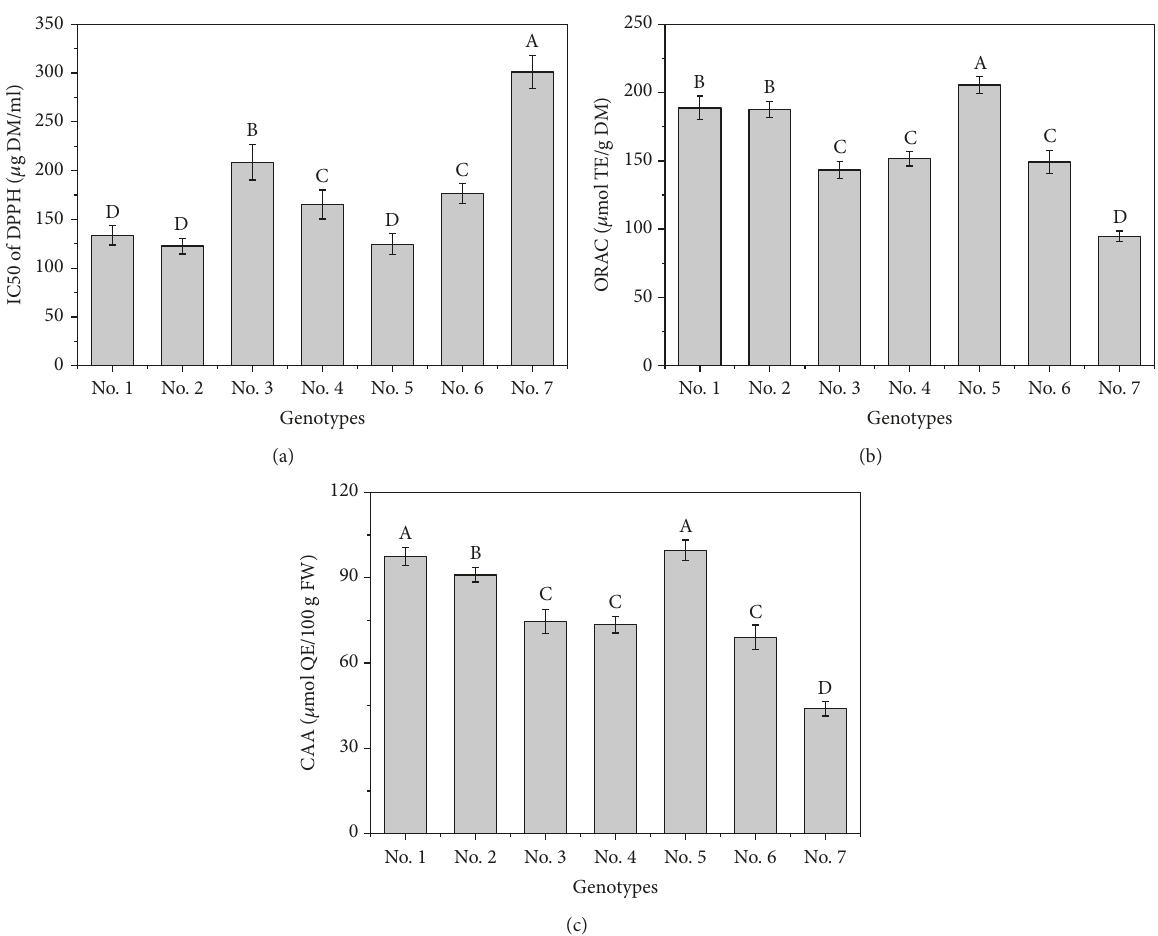
Figure 4: Antioxidant capacity of Chinese dwarf cherry genotypes ( Cerasus humilis (Bge.) Sok.). Numbers 1–7 indicate different genotypes. Different letters indicate significant differences ( 𝑝 < 0.05 ). Data are expressed as mean ± SD ( 𝑛 = 3 ). DM means the dry weight of Chinese dwarf cherry. FW means the fresh fruits weight of Chinese dwarf